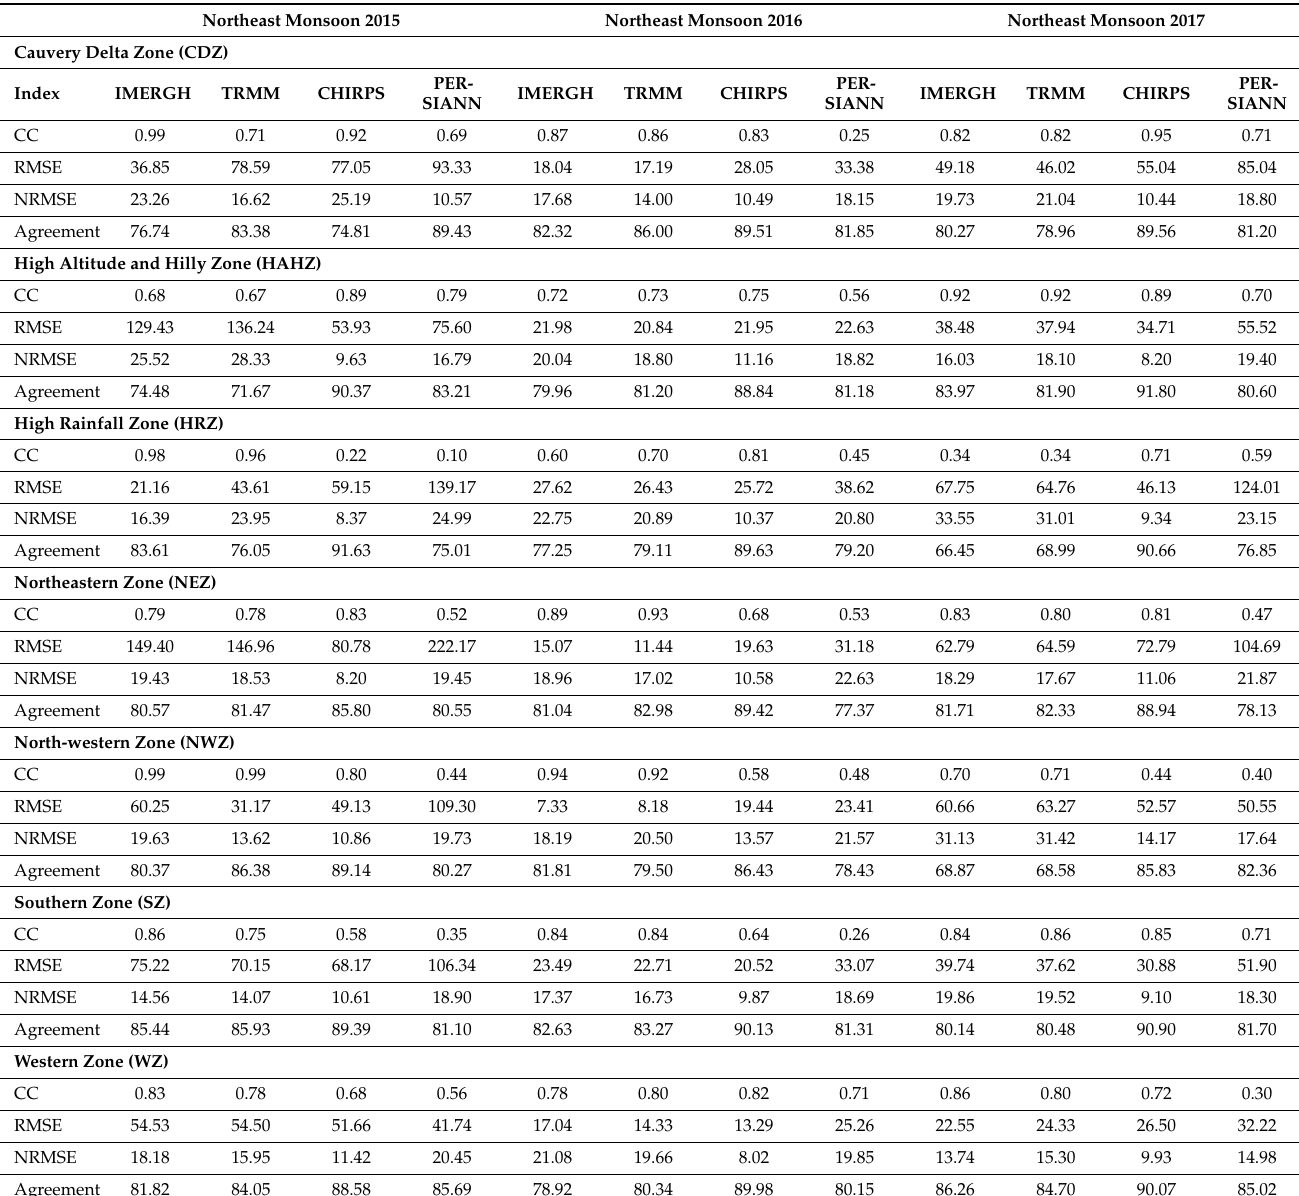
Table 6. Values of the R 2 , RMSE, NRMSE, and Agreement of seasonal evaluation of high-resolution precipitation products for the seven agro-climatic